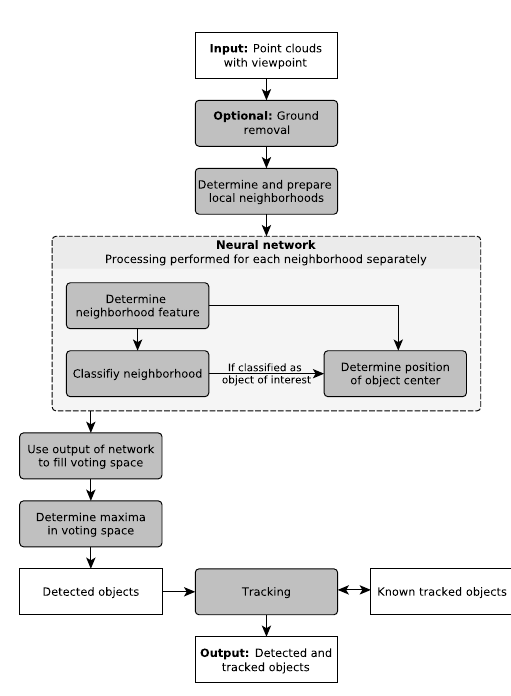
Figure 1. Main processing steps of our approach. The ground removal is optional and improves the runtime